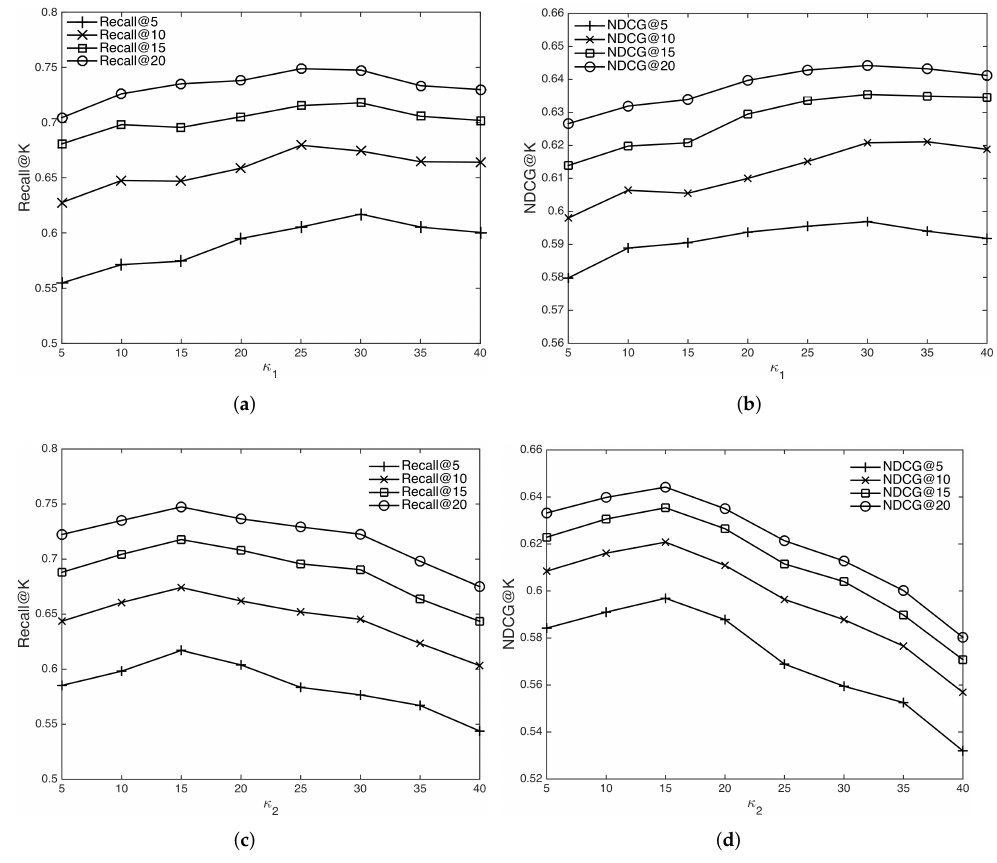
Figure 7. Impact of the threshold τ 1 and τ 2 . ( a ) Recall@K with τ 1 ; ( b ) NDCG@K with τ 1 ; ( c ) Recall@K with τ 2 ; ( d ) NDCG@K with τ 2